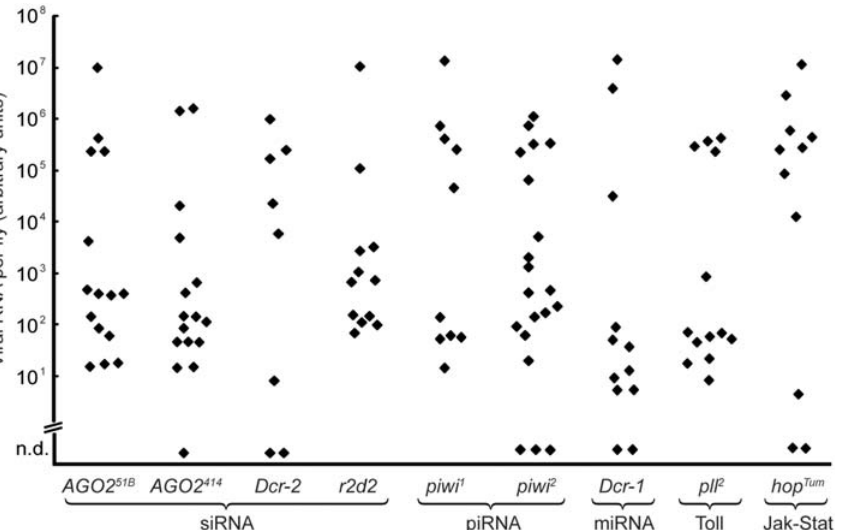
Figure 3. Nora virus control is siRNA-independent. Viral RNA was quantified in Nora virus-infected mutant flies, serially transferred for four days to clean food. AGO2 51B , AGO2 414 , Dcr-2 L811fsx , r2d2 S165fsX , piwi 1 and piwi 2 , are null homozygous mutants. Dcr - 1 Q1147X is a heterozygous null mutant. hop Tum is a constitutive active mutant and pll 2 is a strong loss-of-function allele. Every dot represents the viral load in a single fly. n.d: not detected.